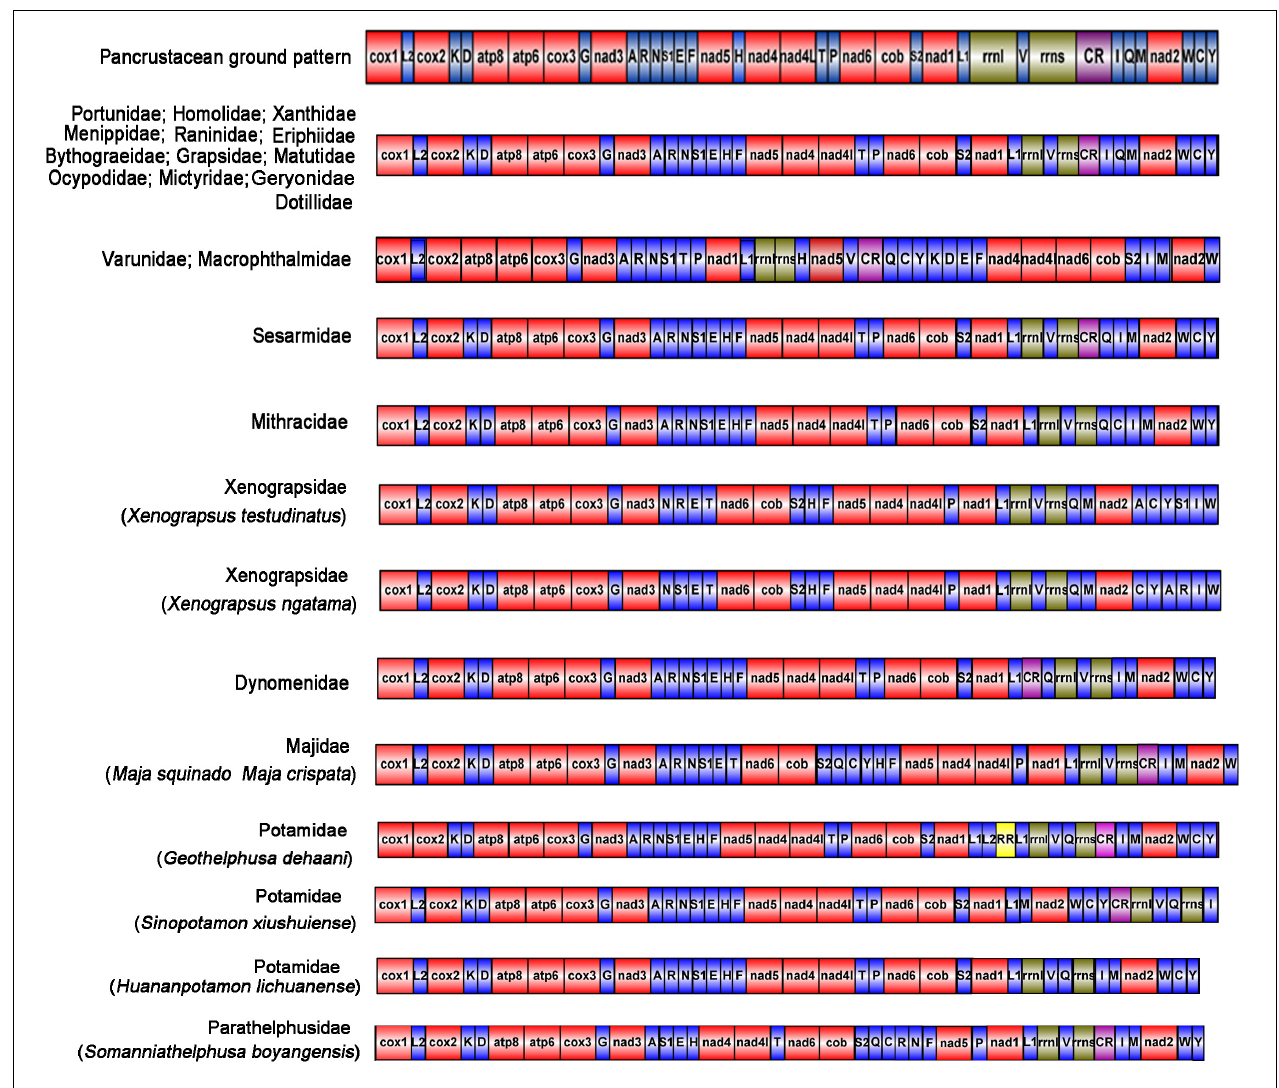
FIGURE 5 | The mitochondrial gene order of all